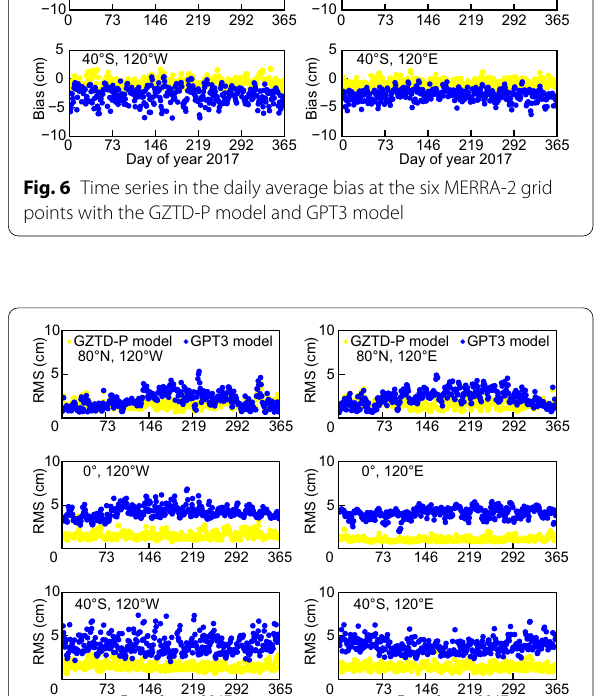
Fig. 7 Time series in the daily average RMS at the six MERRA-2 grid points with the GZTD-P model and GPT3 model